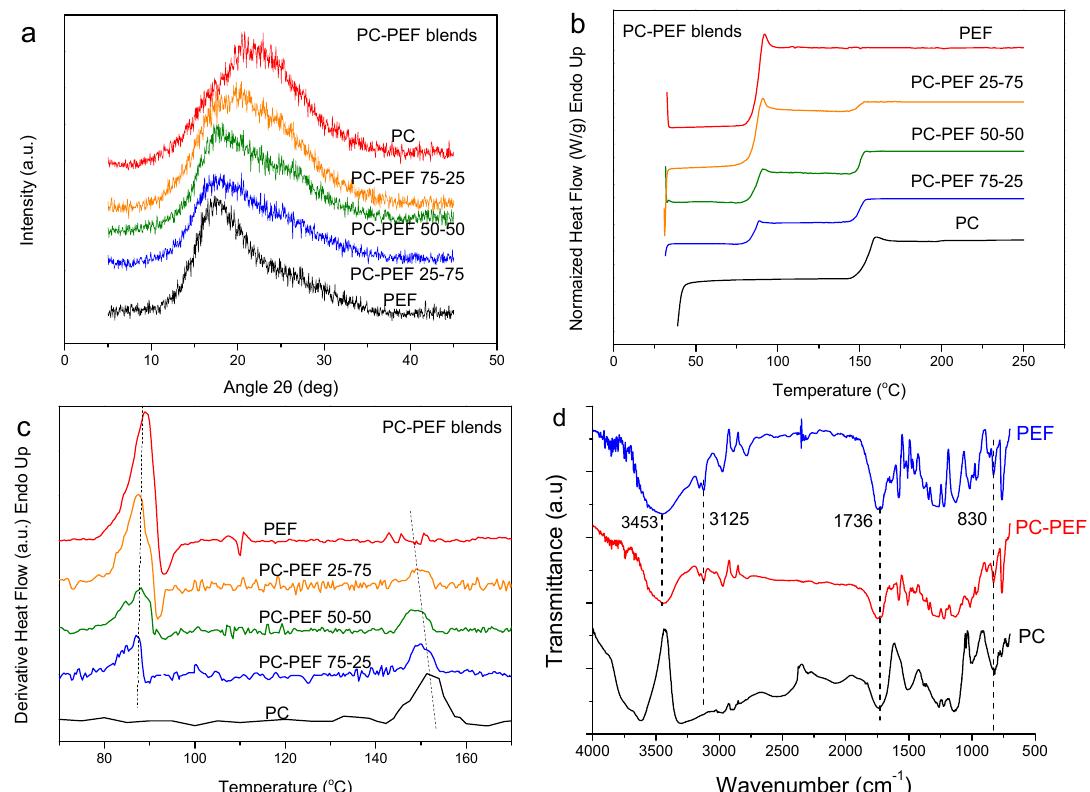
Figure 2. ( a ) WAXD patterns for as received PC–PEF blends, ( b ) DSC heating thermograms, and ( c ) derivative heat flow for melt-quenched PEN–PEF blend samples and ( d ) FTIR spectra of neat PC, PEF and their blend.